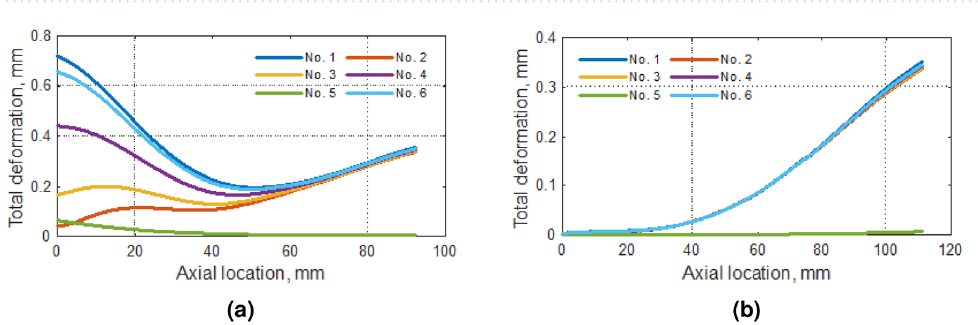
Figure 7. Total deformation along with ( a ) the tip of the blade and ( b ) rounding between the blade and the hub of the compressor.